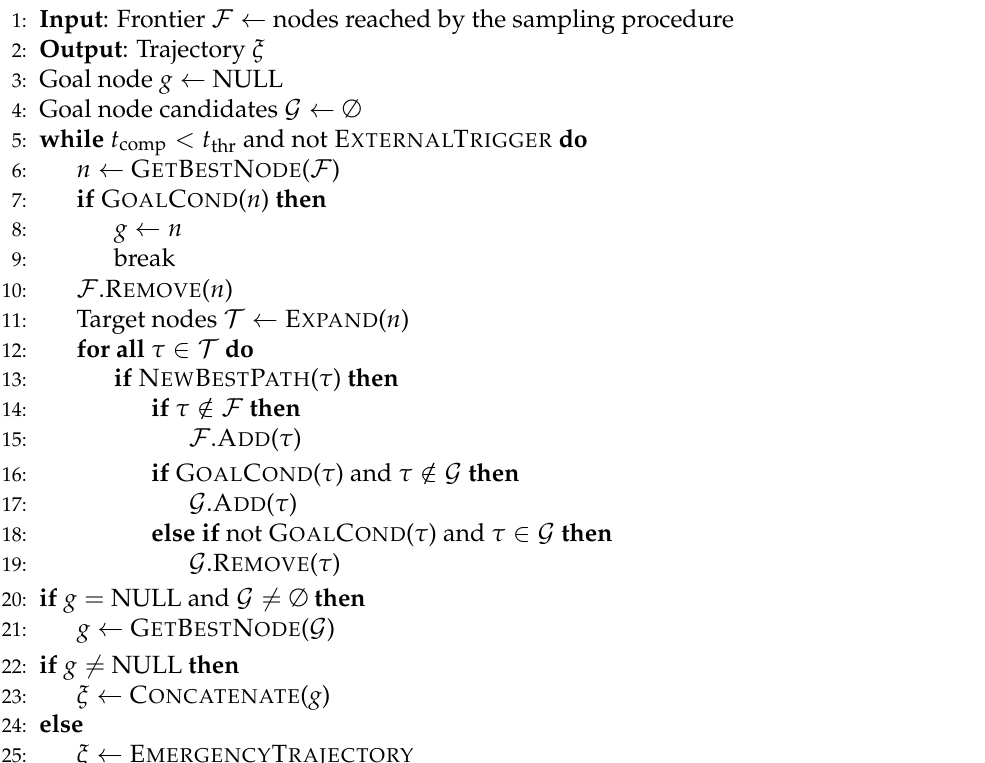
Algorithm 1 UCS with suboptimal goal